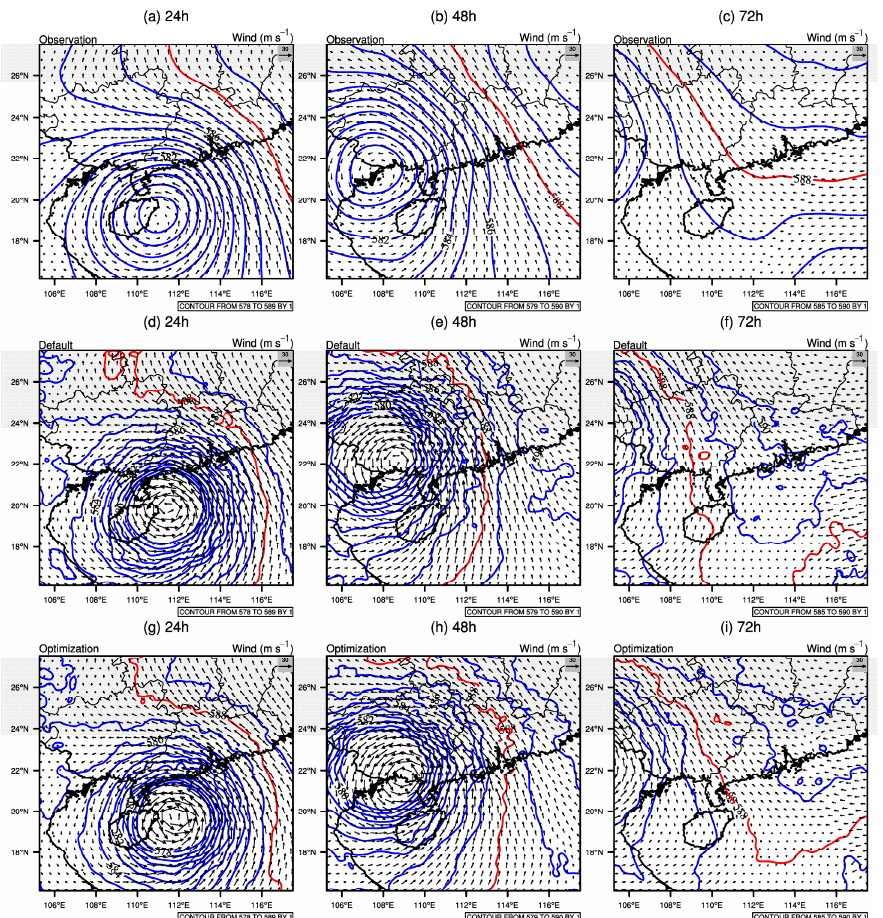
Figure 9. Comparisons of simulated 500 hPa high-altitude fields including geopotential height and wind field for event (2) at 24, 48, and 72 h lead times. ( a )–( c ) represent the observed 500 hPa high-altitude fields at 24, 48, and 72 h lead times respectively; ( d )–( f ) represent the simulated 500 hPa high-altitude fields with default parameters at 24, 48, and 72 h lead times respectively; ( g )–( i ) represent the simulated 500 hPa high-altitude fields with optimal parameters at 24, 48, and 72 h lead times respectively. The precipitable water is the total amount of water vapor in a vertical column with unit cross-sectional area. It is an important indicator of precipitation. Figures 11 and 12 show a comparison event (5) respectively. To better demonstrate the improvement in the precipitable water simulation by the WRF model with optimal parameters, the areas with high water-vapor content were shaded. The − 2 − 2 shaded areas in Figures 11 and 12 represent values higher than 65 kg m and 70 kg m respectively. As shown in Figures 11 and 12, the optimal simulations reduced the shaded area of the default simulations to be closer to observations, especially for the area around the typhoon